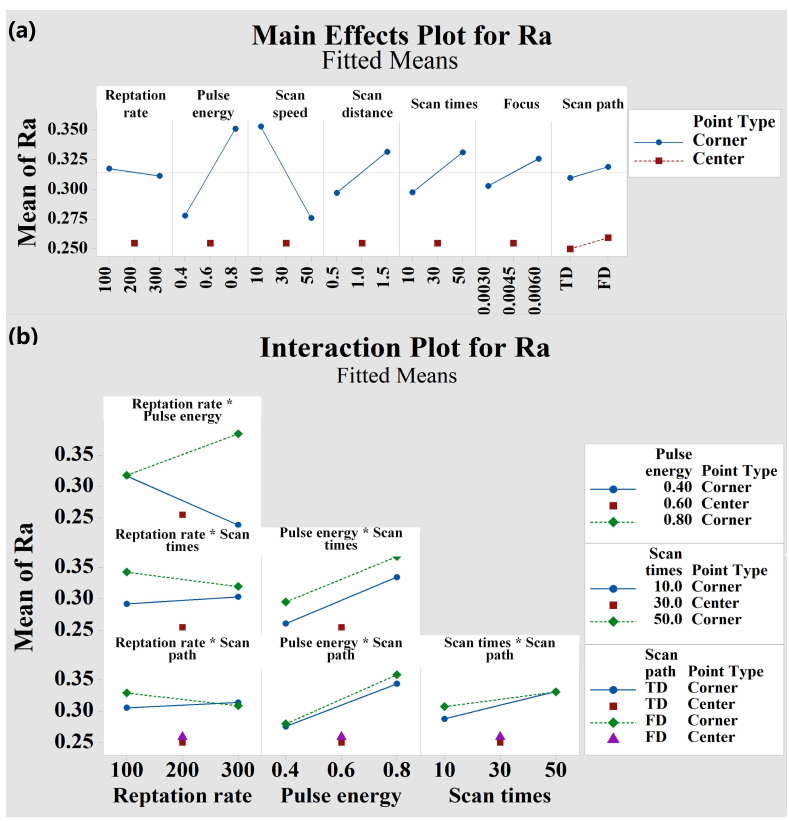
Figure 4. ( a ) Main effect plot of factors affecting the response variable Ra . ( b ) Interaction plot of factors affecting the response variable Ra